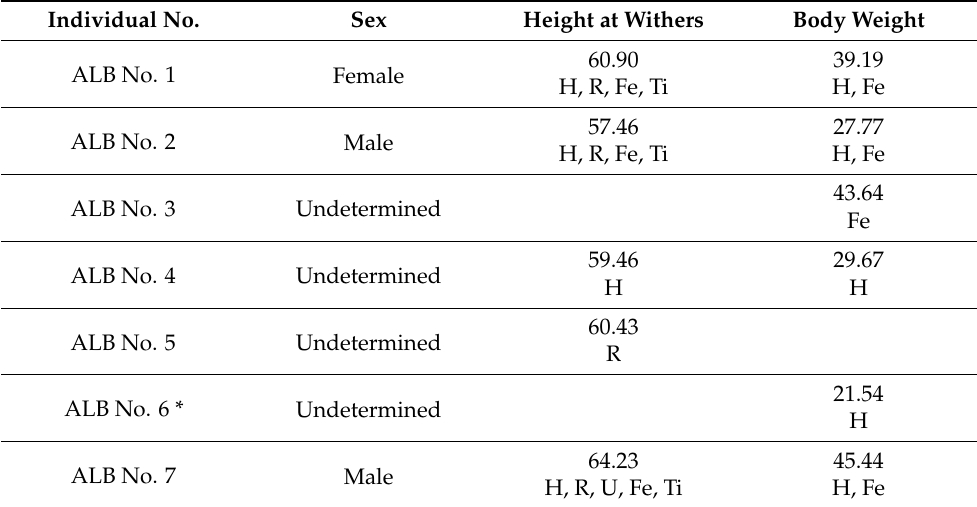
Table 4. Distribution of the sex, height at withers, and body weight of the Alaybeyi dogs. Individual